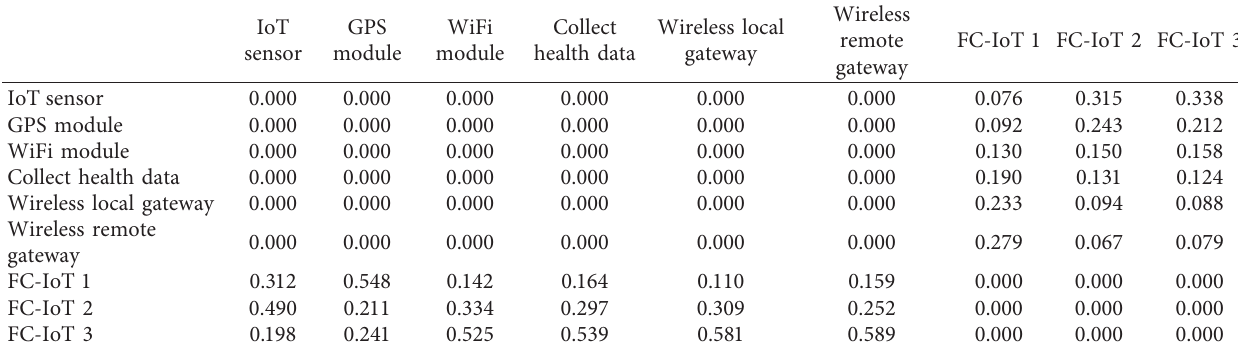
Table 9: Weighted matrix.